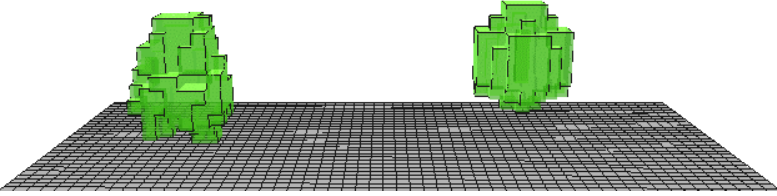
Figure 5. Simple model area for the Proof-of-concept simulations. ( Left) : Deciduous L-Tree; ( Right) : deciduous Parametric-Tree.